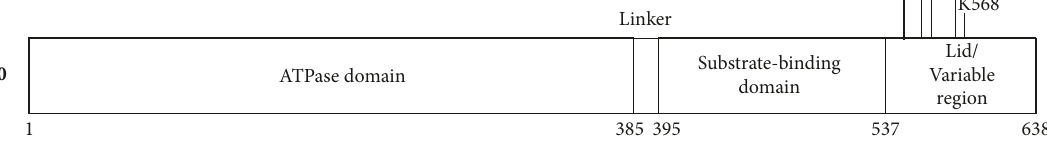
Figure 15: HSP70 lysine methylation sites (based on PhosphoSite